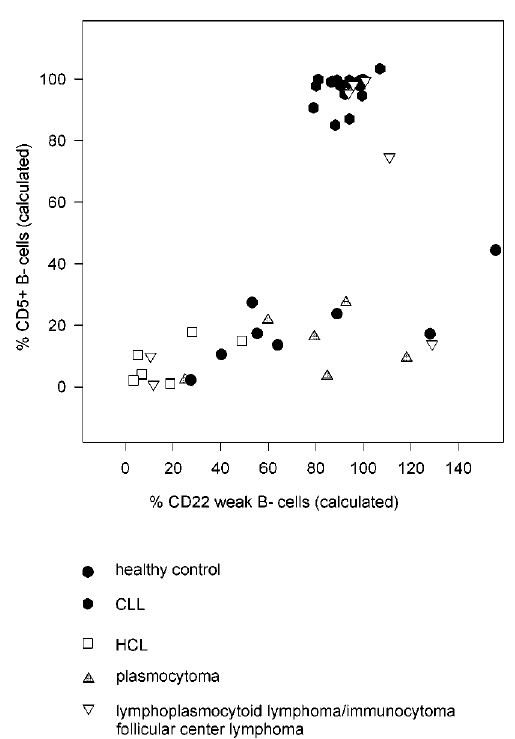
Fig. 5. Presentation of the B-CLL immunophenotype cluster within a dotplot, summarizing the expression of CD19 and CD5 as well as the antigen density of CD22. Antigen expression was determined for B-cell populations within a spreadsheet by correlation of results from different